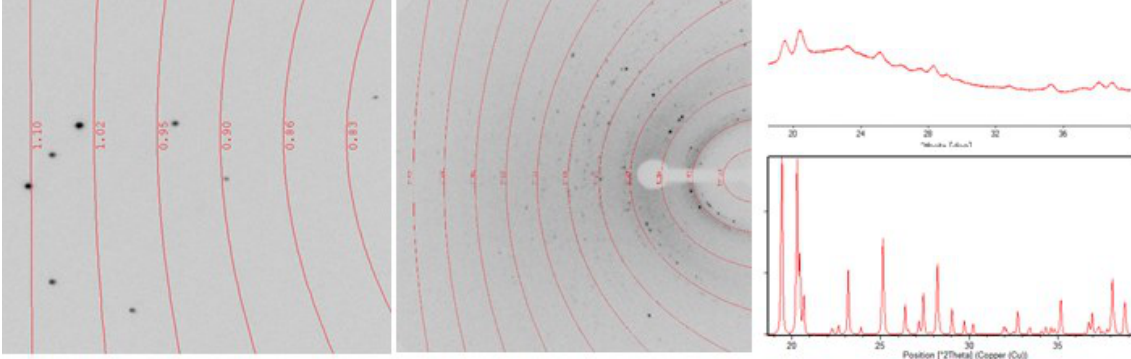
Fig. S3. Left: one frame of single crystal data collection of compound 1 . The single crystal was surrounded with vacuum grease and the experiment was run at 150 K in the stream of liquid nitrogen, yielding the unit cell with the following parameters: a =12.242 Å, b = 9.597 Å, c = 15.563 Å, β =108.88° characteristic for 1